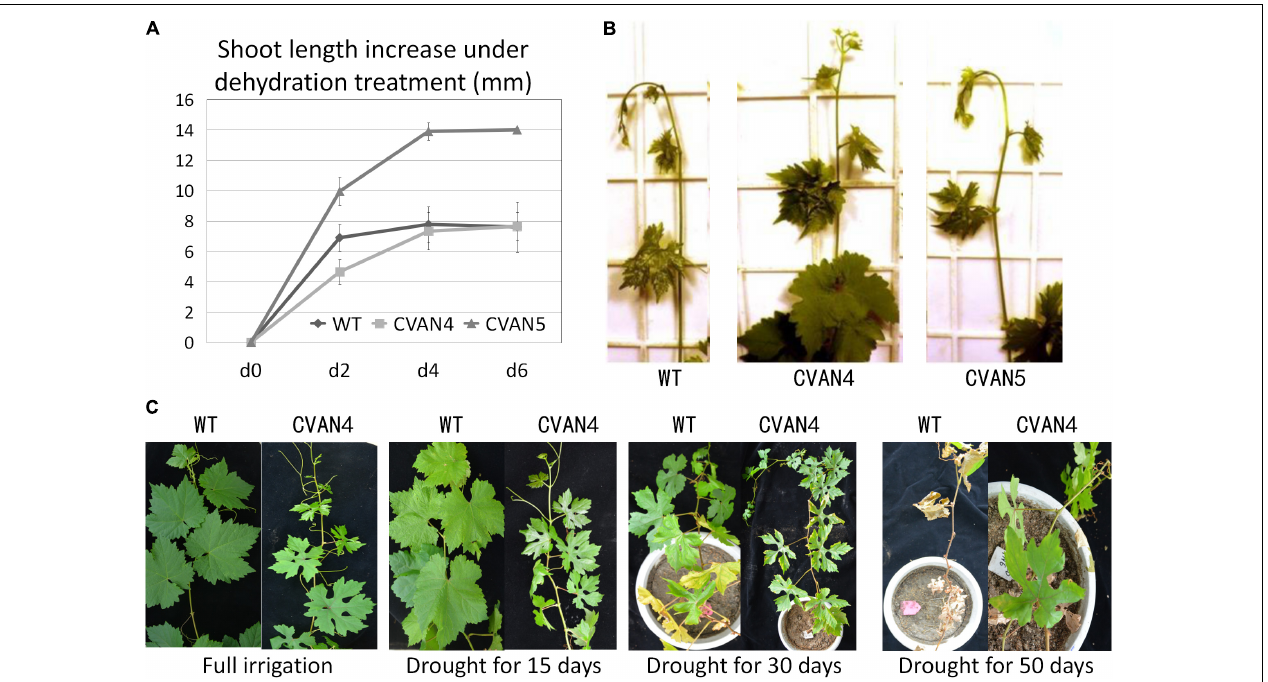
FIGURE 5 | Improved plant growth rate and drought resistance. Increased growth rate of transgenic and non-transgenic plants after dehydration treatment (A) . Plant length was measured at 0, 2, 4, and 6 days. Values are means ± SD for three independent experiments. Shoot tips of the WT and transgenic plants after dehydration for 6 days (B) . Drought tolerance of WT and transgenic plants (CVAN4) in a growth room (C) . Images were obtained for plants without irrigation on days 0, 15, 30, and